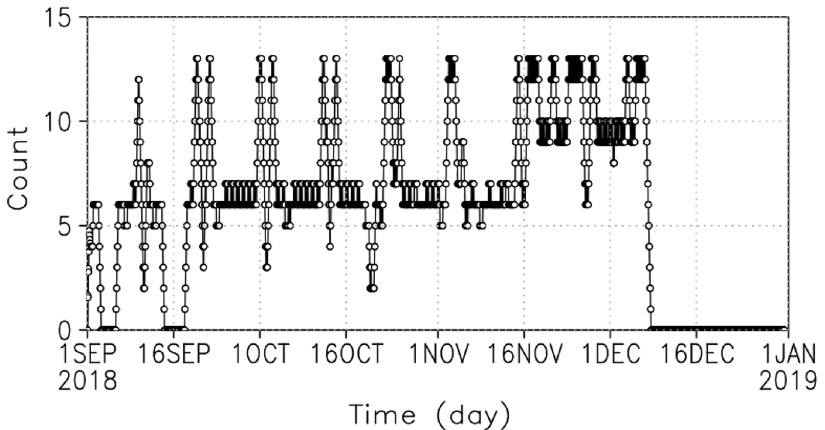
Figure 5. Time variation of observation frequency. Each point represents the sum of the observations for the preceding and following 12 h.